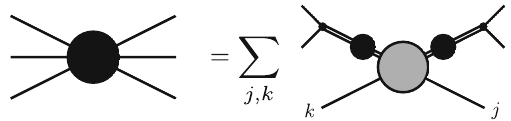
Fig. 6 Diagrammatic representation of the isobar approximation amplitude in Eq. (15). The double lines with the black disk represents (σ ) , while the gray disk represents the isobar– the isobar amplitude f s j j spectator amplitude A kj ( p (cid:6) ; p )